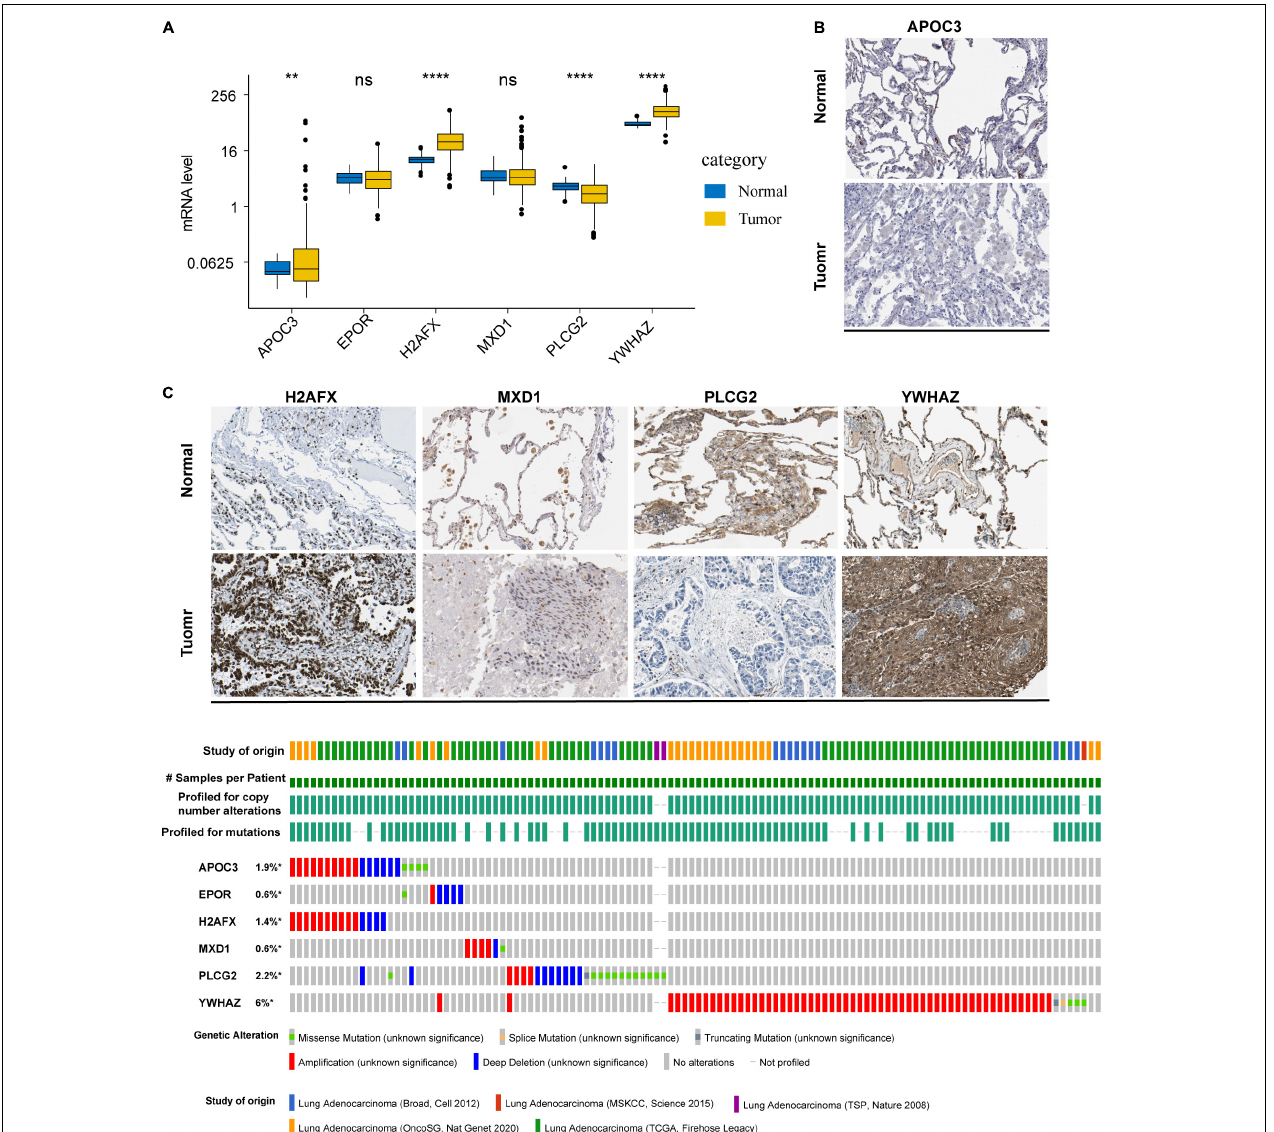
FIGURE 2 | mRNA and protein expression profile and alterations of the ARGs in LUAD. (A) The mRNA expression profiles of ARGs between normal and tumor tissues in the training set. ** P < 0 . 01 and **** P < 0 . 0001. (B) Representative immunohistochemical pictures of ARGs protein expression which were obtained from the Human Protein Atlas database (the data of EPOR were not available). (C) Genetic alterations in the ARGs in LUAD were determined using the cBioPortal database. * P < 0 .